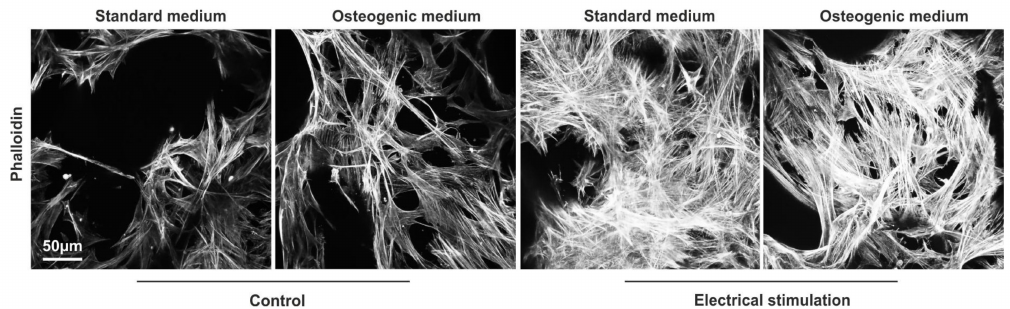
Figure 8. Electrical stimulation (ES) of adipose-derived stem cells (ASCs) induces profound re-arrangements of the actin cytoskeleton. ASCs in anionic nanofibrillar cellulose hydrogels (aNFC) were di ff erentiated in osteogenic di ff erentiation medium for 21 day with and without electrical stimulation (ES) followed by staining of the actin cytoskeleton using phalloidin with subsequent confocal microscopy. Image analysis revealed highly aligned and dense network of F-actin fibres in cells in osteogenic di ff erentiation medium and in cells exposed to ES independent of the culture condition. Images show maximum intensity projections of confocal z-stacks. Scale bar: 50 µ